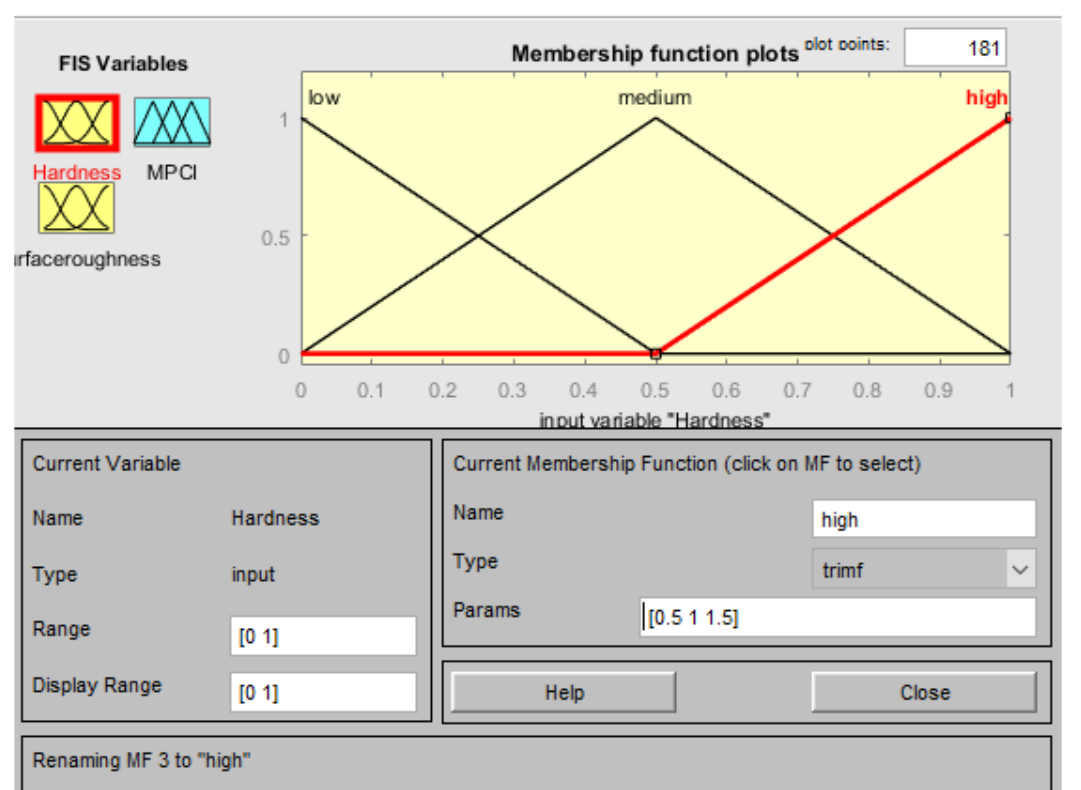
Figure 7. Membership function for the hardness.